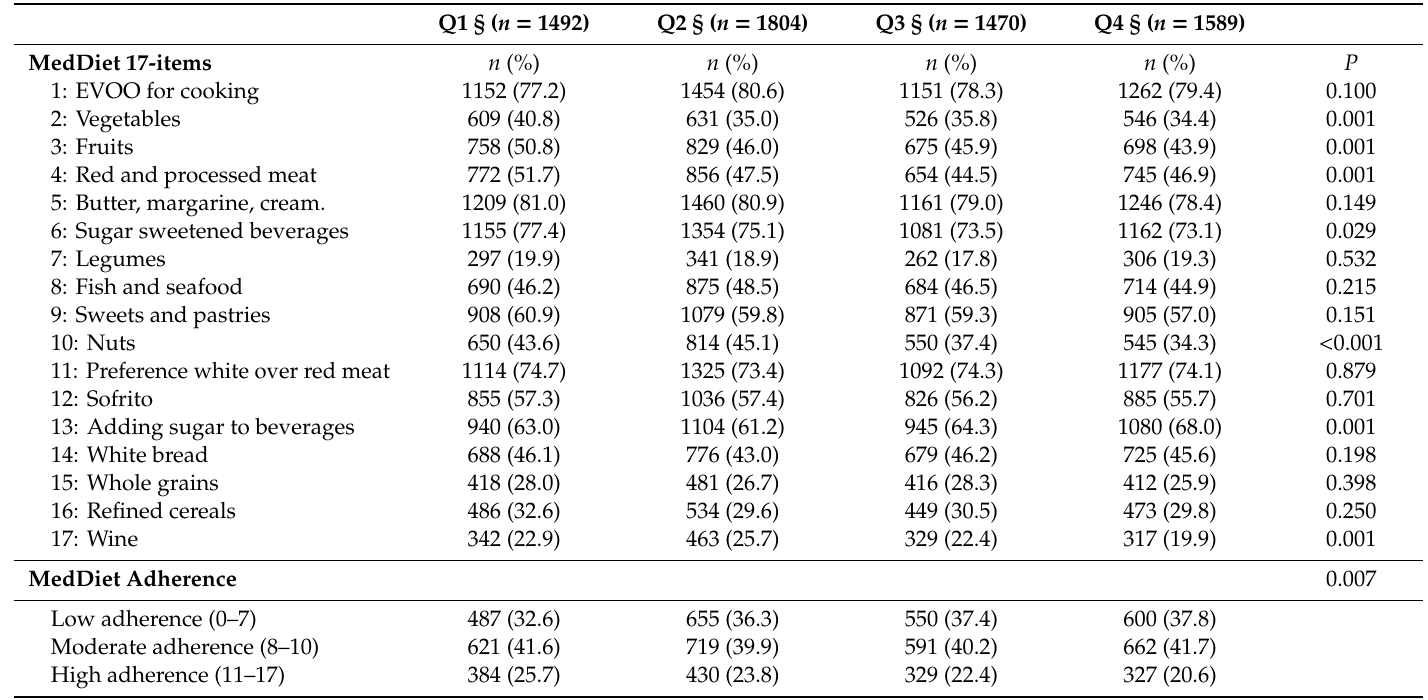
Table 3. Adherence to the Mediterranean Diet 17-items according to the percentage of desired weight loss